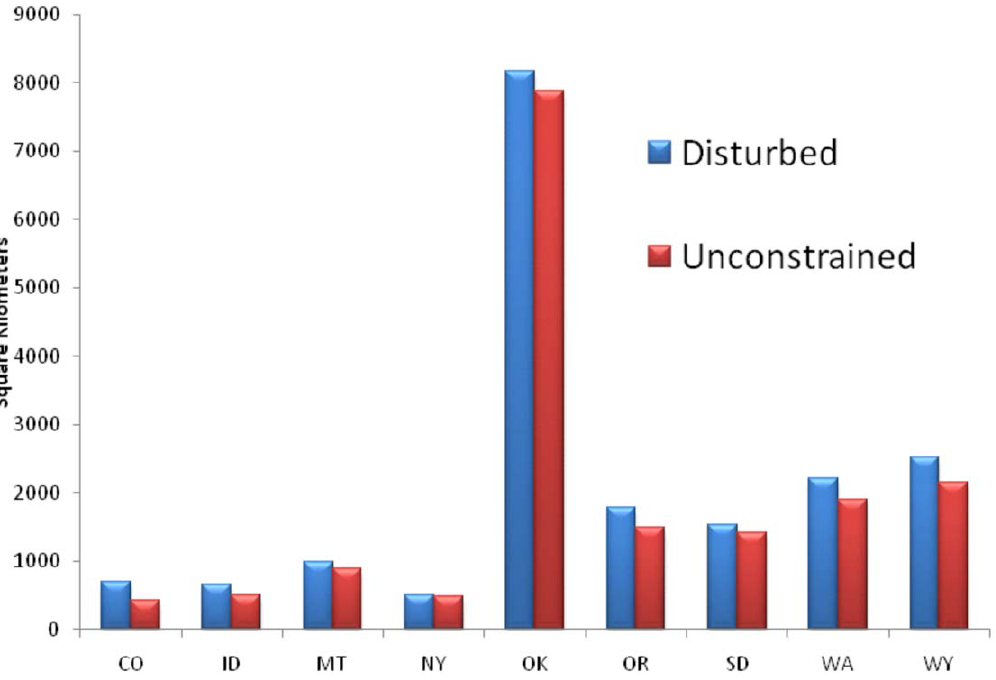
Figure 3. Minimum number of square kilometers needed to meet DOE projections for disturbance restricted (blue) or unconstrained (red) scenarios. For simplicity we have only included states where disturbance focused development would result in an increased area needed to meet the DOE projections. For all other states there is either not an increase in land needed or the state is unable to meet DOE projections on disturbed lands.